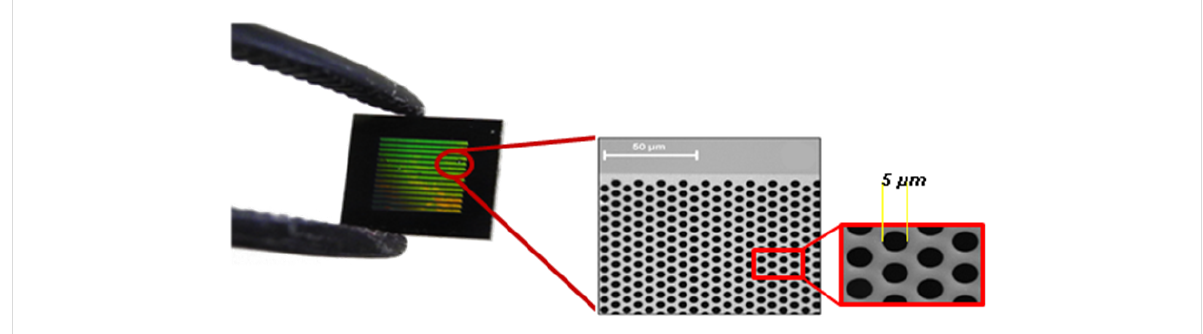
Figure 5: Macroporous commercial silicon nitride microsives purchased from Aquamarijn Micro Filtration BV (Zutphen, Netherlands), having on top a Si 3 N 4 membrane (5 mm × 5 mm × 0.6 mm) with macropores arranged in a hexagonal setting and diameter of 5 μ